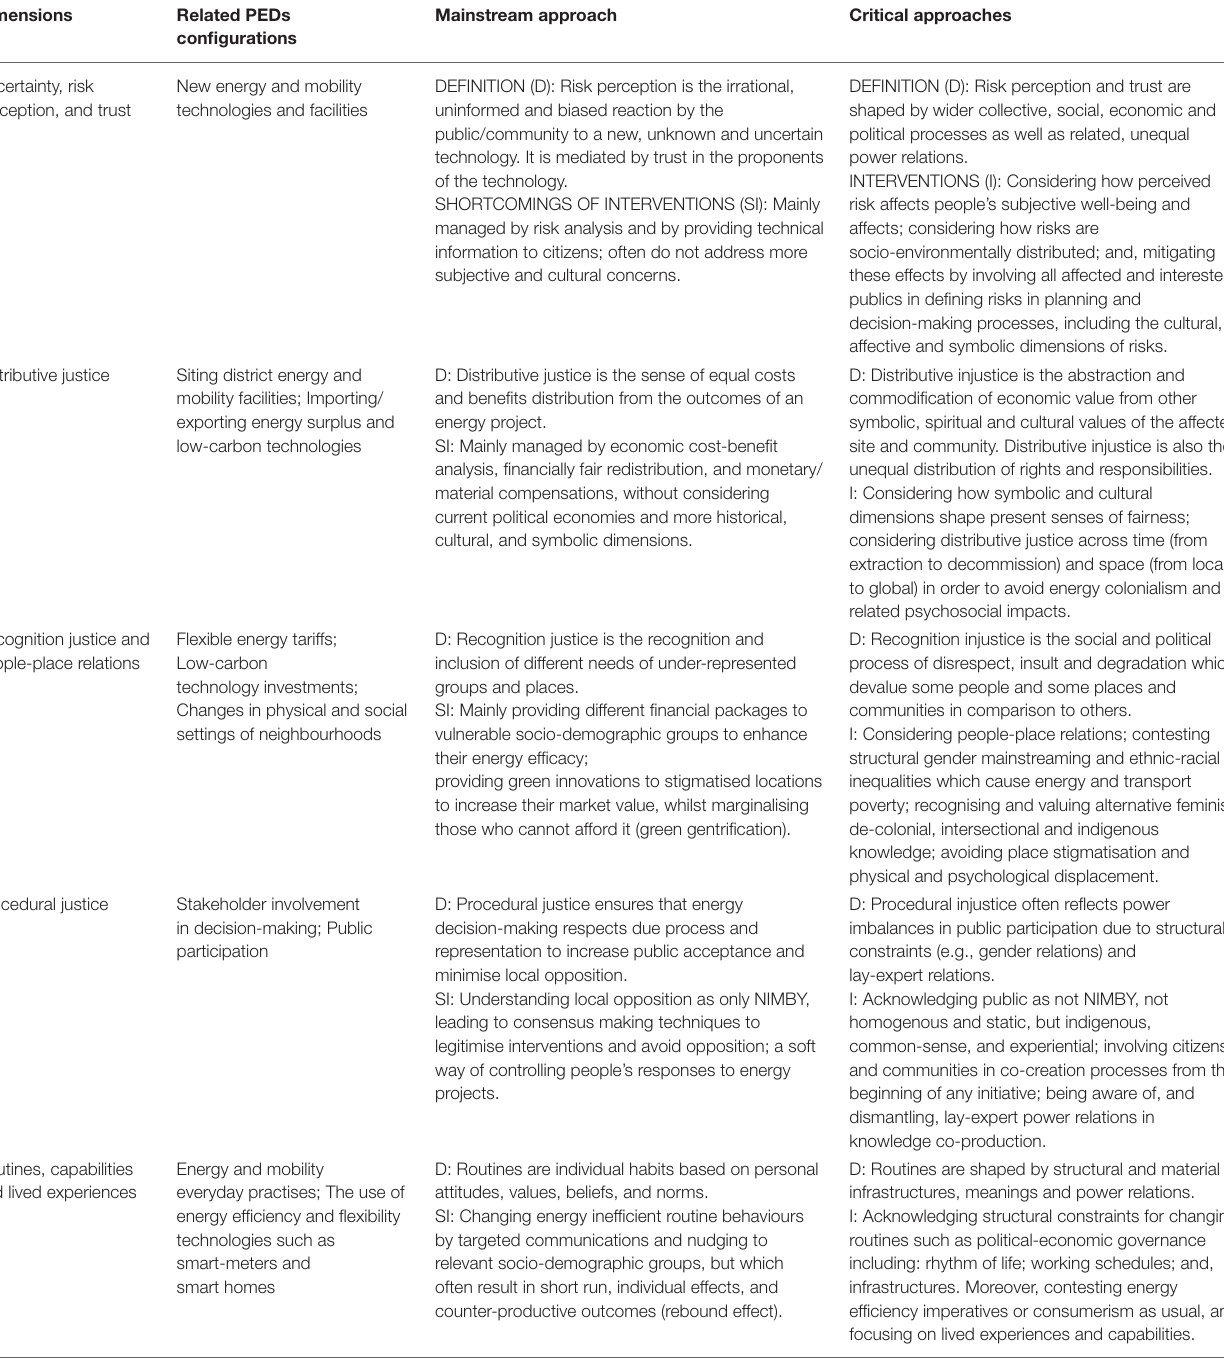
TABLE 1 | Summary of mainstream and critical approaches to relevant socio-psychological factors for human-centric PEDs.